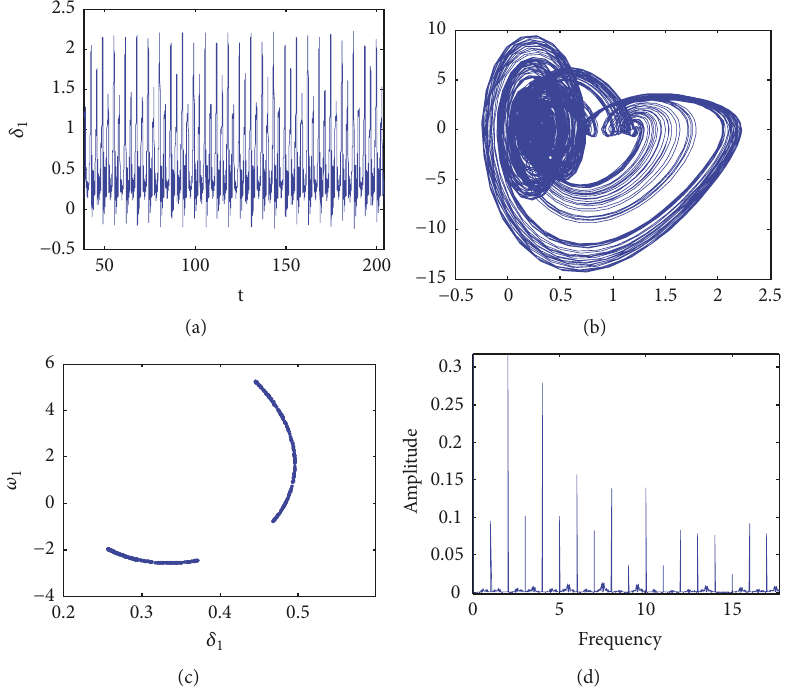
Figure 9: Chaotic motion ( 𝑉 𝐵 = 0.64 ). (a) Time history. (b) Phase portrait. (c) Poincar´e map. (d) Frequency